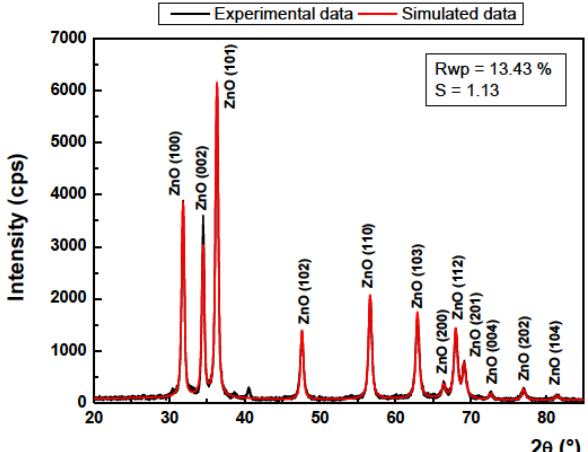
Figure 2: XRD pattern of ZnO-1.4wt% Graphene powder obtained at pH=14, after drying process at 150 ∘ C (black curve). Red curve stands for the simulated data using Rietveld